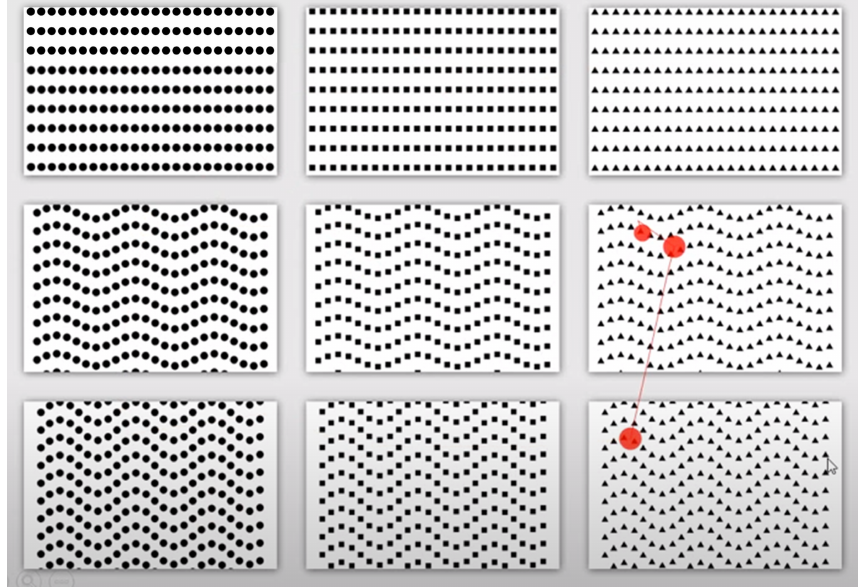
Figure 19. Sequence detection of